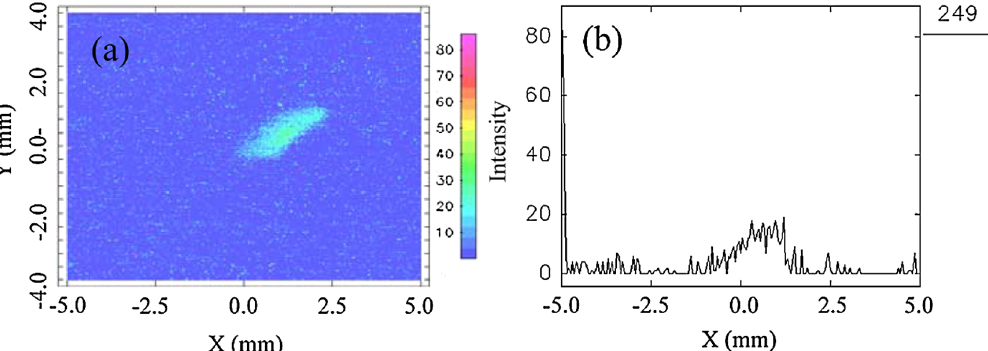
compression.FIG. 4. (Color) OTR beam image (a) and horizontal profile (b) sampled through distribution after BC with L2 phase ¼ 12 degrees , close to minimum